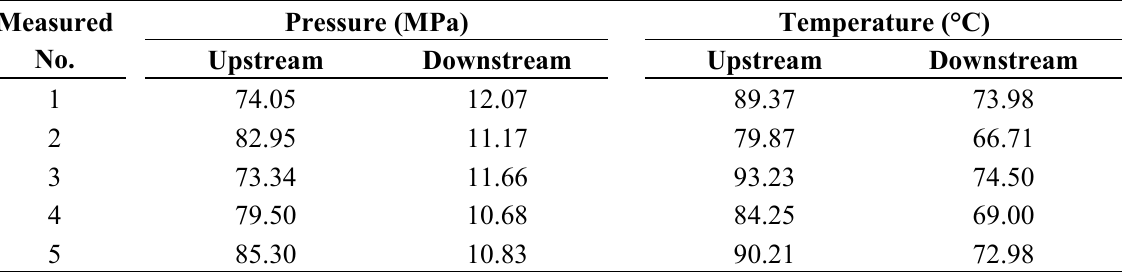
Table 4. Measured upstream and downstream parameters of DINA24.